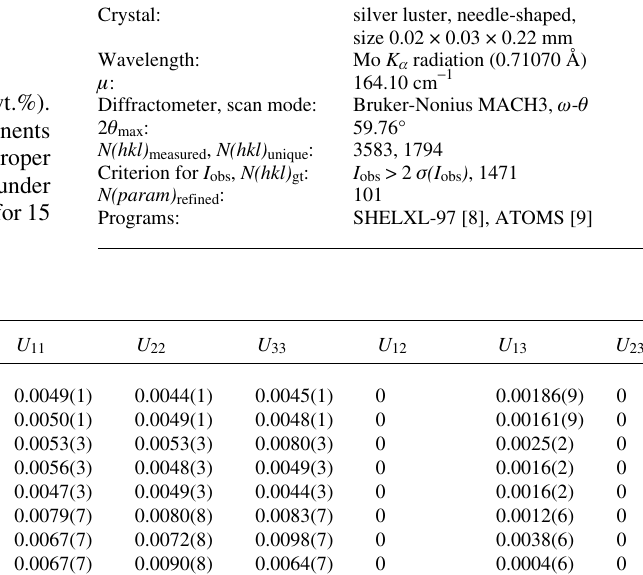
Al 23 Ni 6 Sm 4 , monoclinic, C 12/ m 1 (no. 12), a = 15.939(3) Å, b = 4.0967(6) Å, c = 18.320(3) Å, (cid:7) = 113.09(2)°, V = 1100.4 Å 3 , Z = 2,